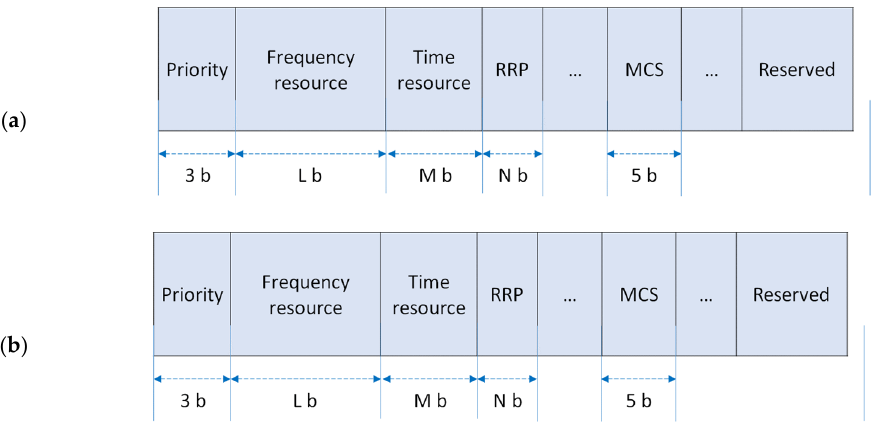
Figure 7. SCI Format 1 in cellular V2X: ( a ) in NR V2X [20]; ( b ) in LTE V2X [6].